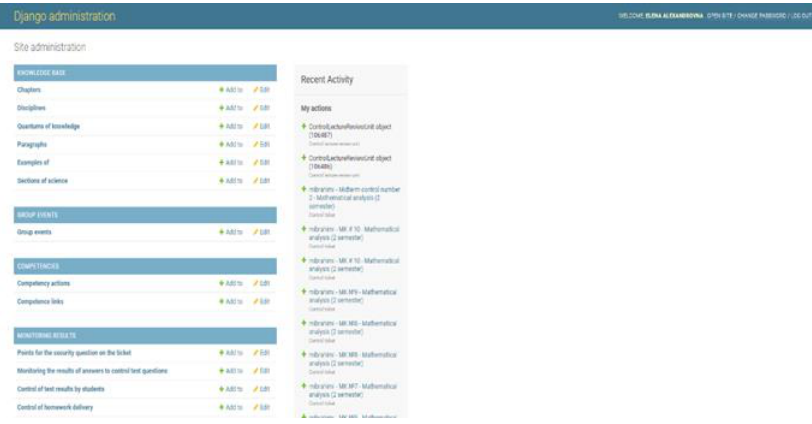
Fig. 2. The window of the «Administration» subsystem in the Nomotex DLS.